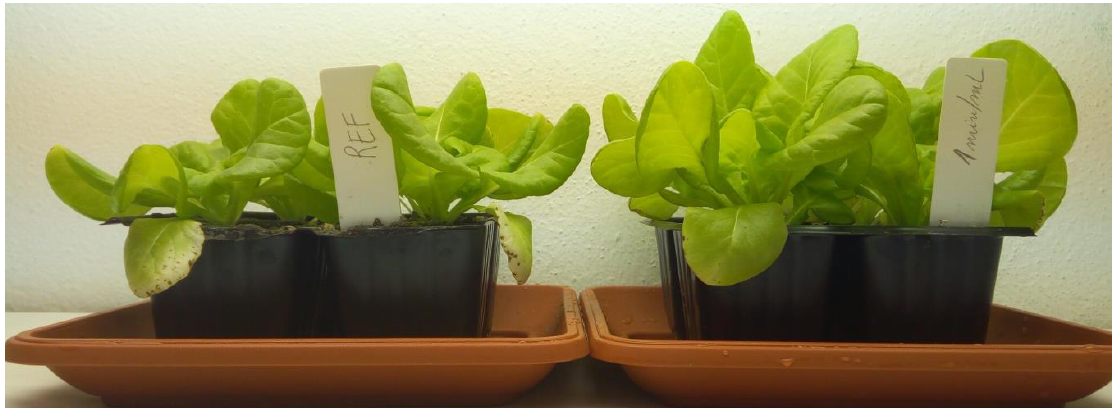
Figure 2. Photography of lettuce plants after 5 weeks of cultivation in soil irrigated with tap water (control, left ) and the plasma activated water (water activation time 1 min·mL −1 , right ).